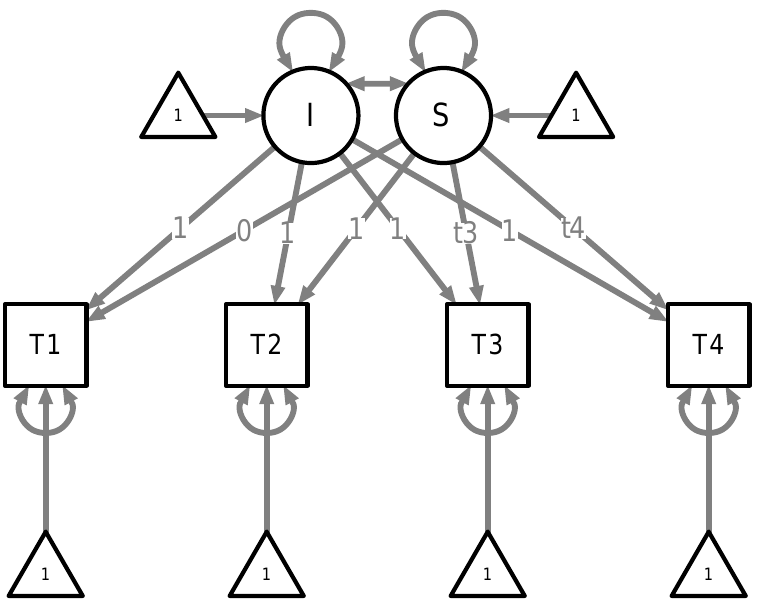
Figure 4. Growth curve model used for all three diffusion model parameters. T1 to T4 refer to the individual posterior medians of the respective diffusion model parameter at a certain time point. I = Intercept, S = Slope. The slope loadings t 3 and t 4 are treated as free parameters and thus estimated.